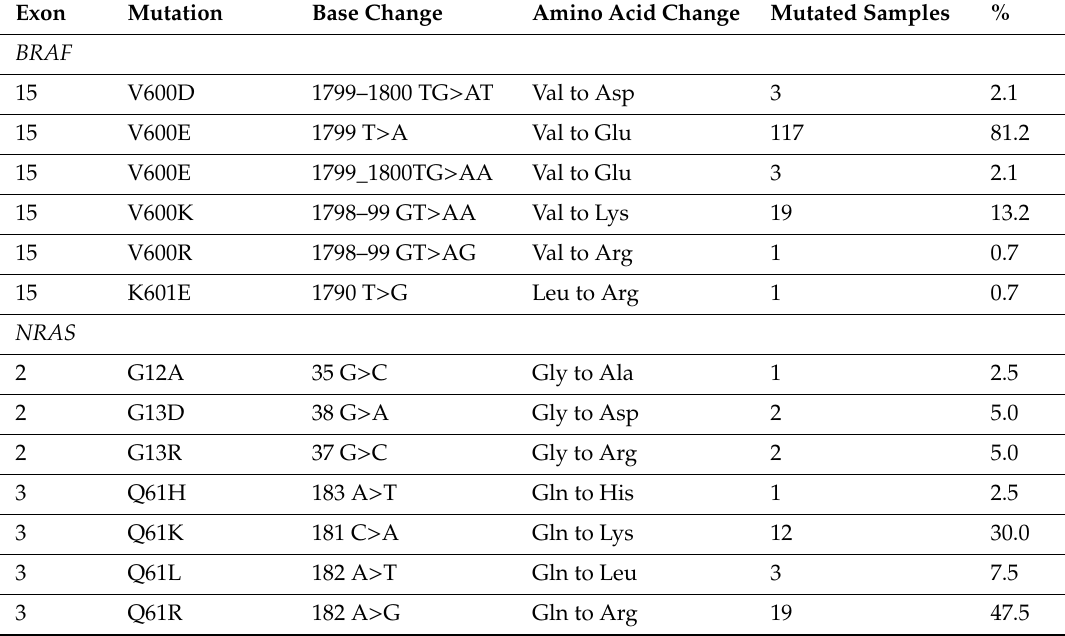
Table 3. BRAF and NRAS mutation spectrum. Frequencies are related to the total amount of mutated cases in BRAF ( n = 144) and NRAS ( n = 40)